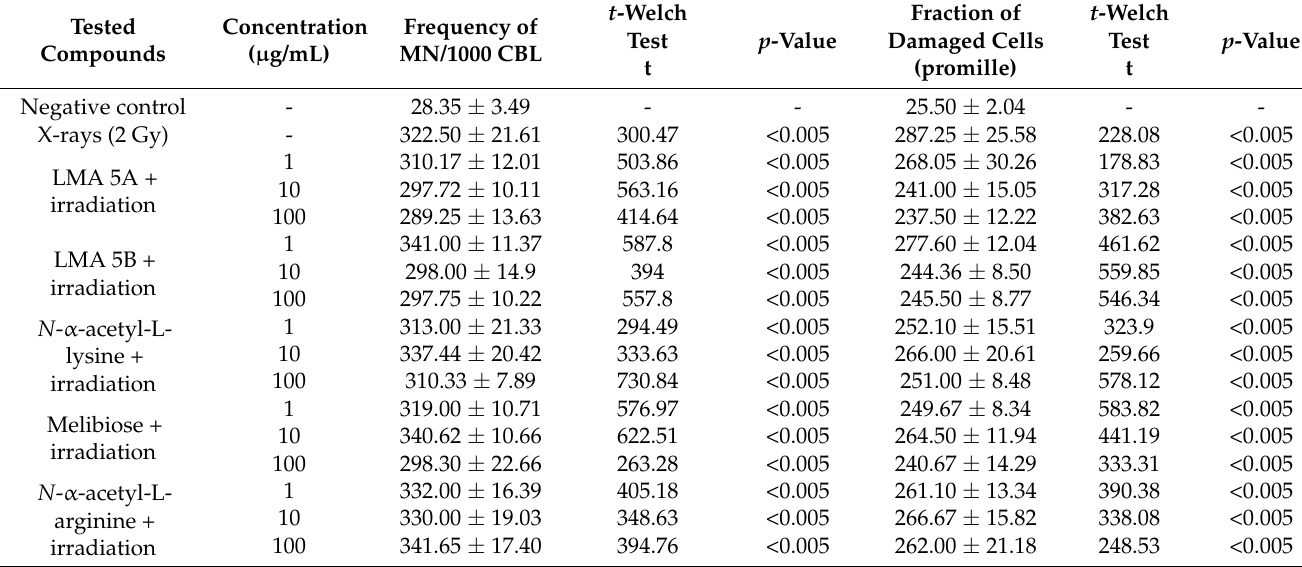
Table 3. Effect of advanced glycation end-products on the formation of micronuclei induced by X-radiation in human lymphocytes in